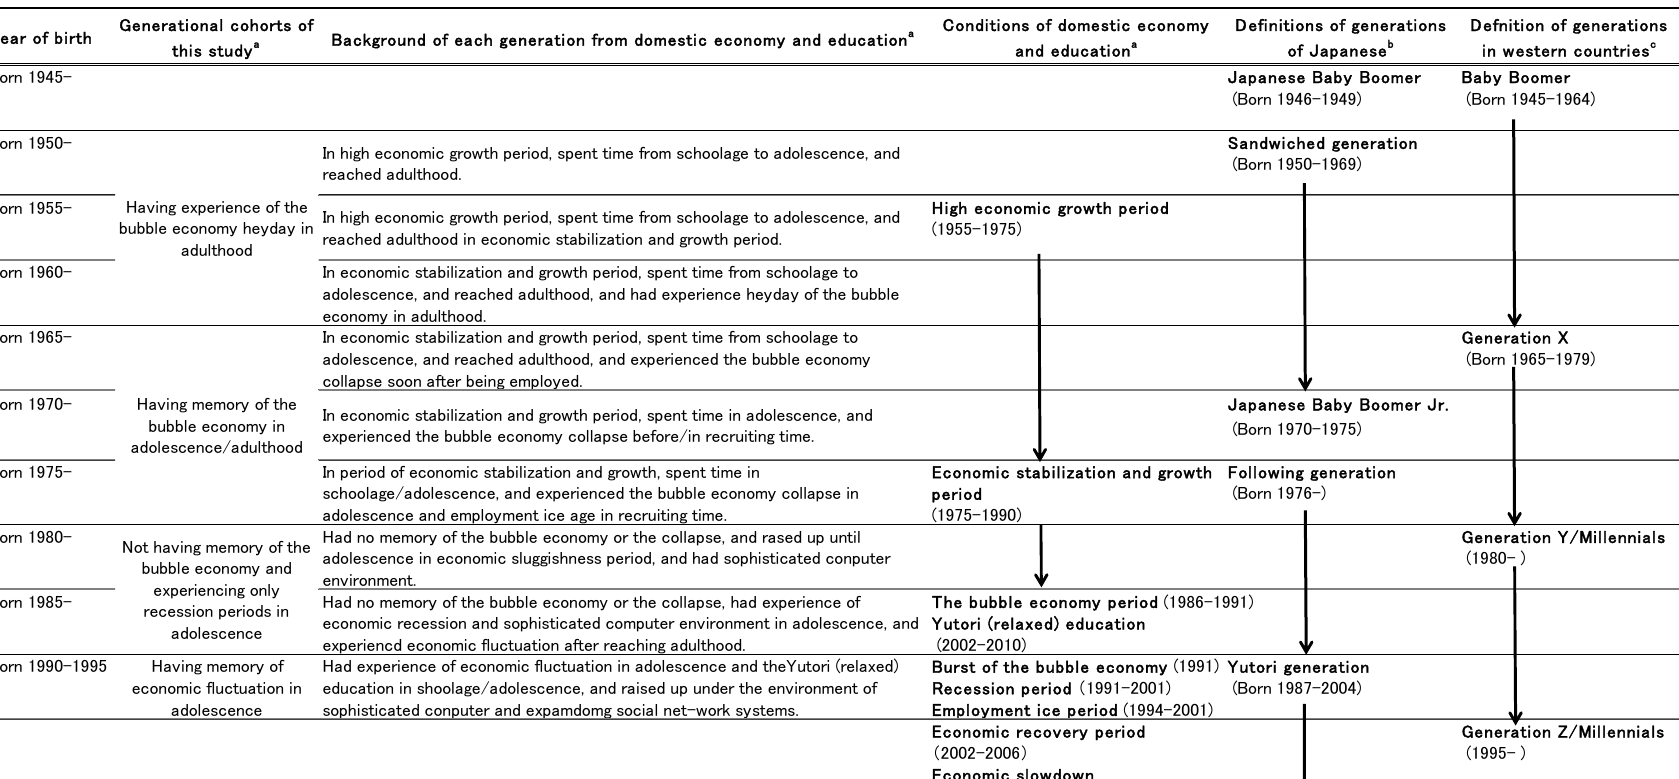
Figure A1. Four generational cohorts based on year of birth. a References [24], b References [30,31], c References [26,27].